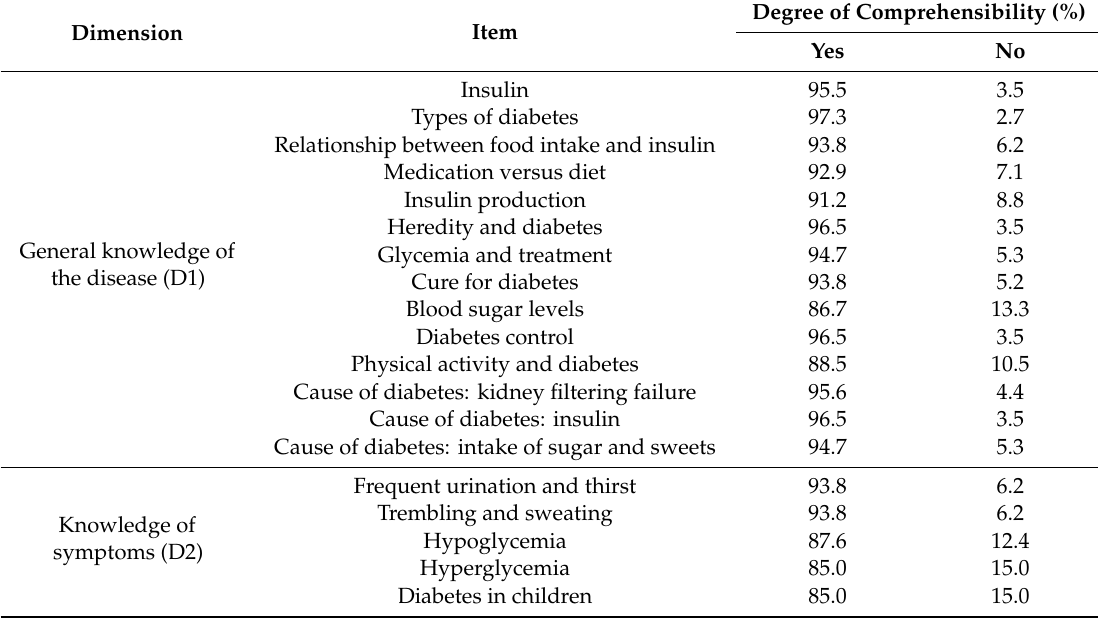
Table 7. Percentages of comprehensibility of the dimensions and their items in the final version of the validated